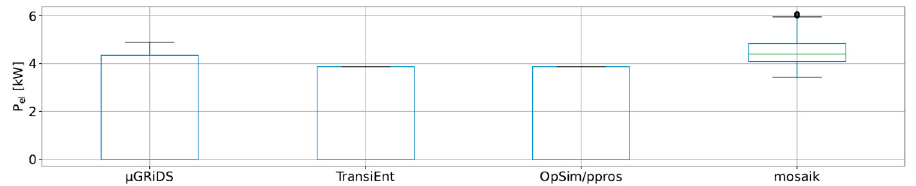
Figure 10. Boxplot of the HP electrical demand.